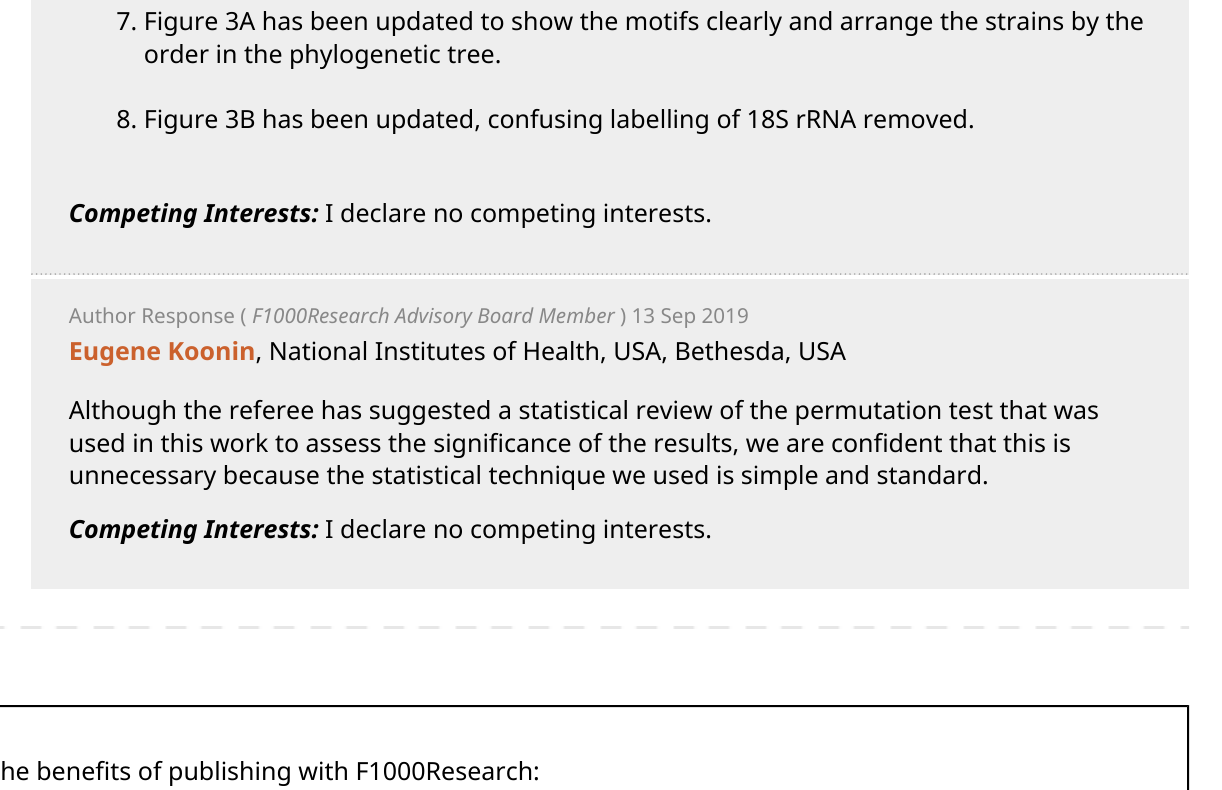
Figure 3B has been updated, confusing labelling of 18S rRNA